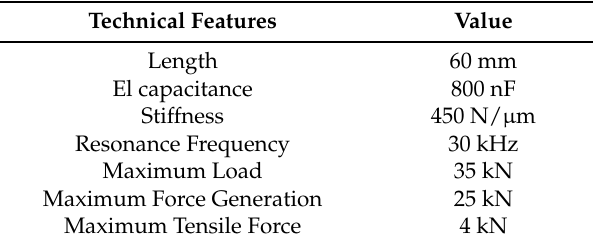
Table 2. Actuators’ technical features.